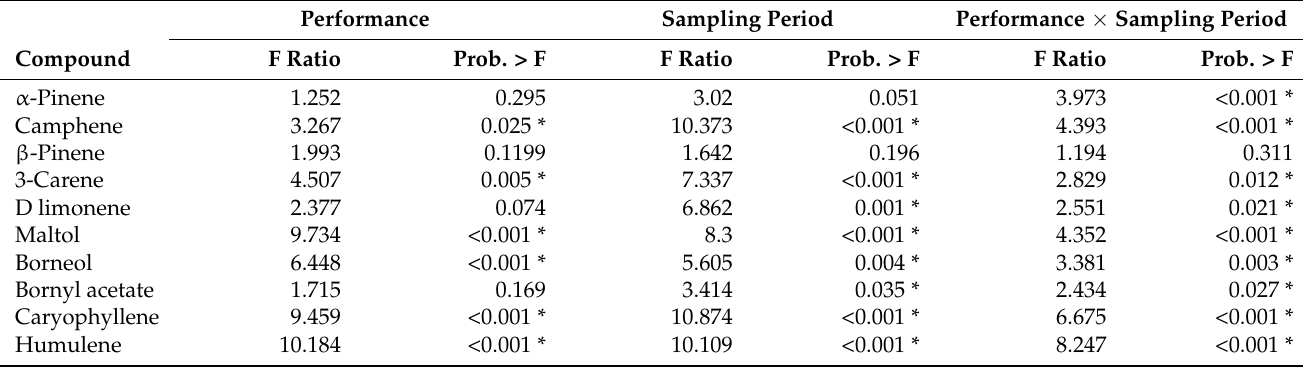
Table 1. p values for all 10 quantifiable HIPV compounds. Degrees of freedom (df) for each compound are as follows: Performance Group df = 3, Sampling Period df = 2, and